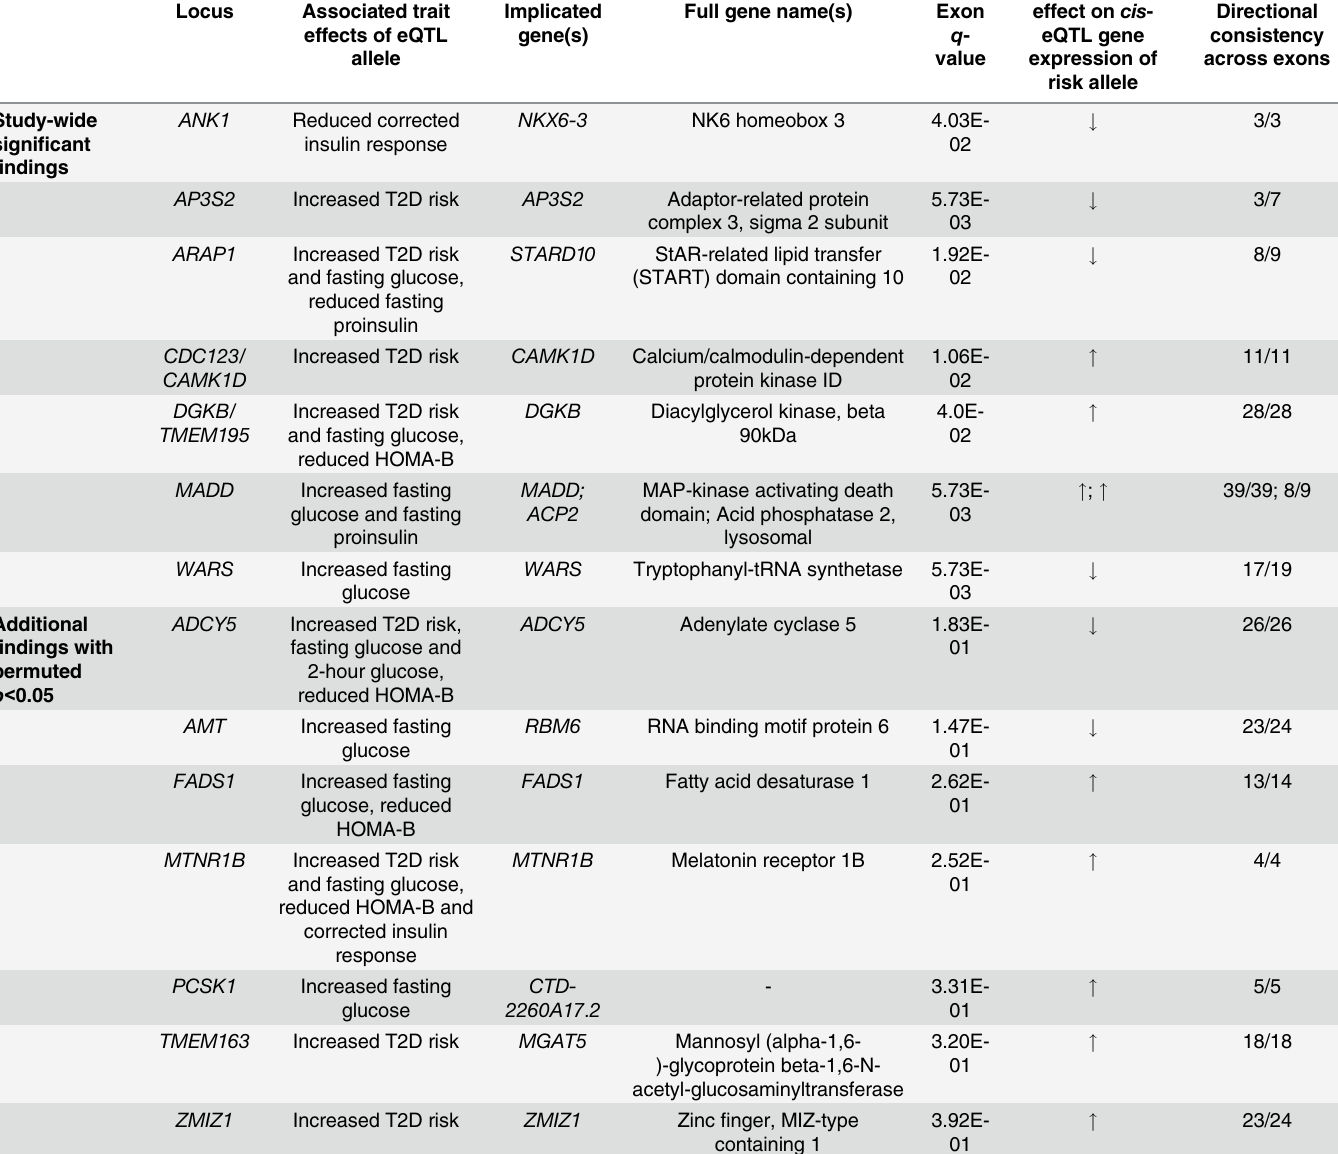
Table 1. Fourteen loci with co-localizing islet exon-eQTL and GWAS signals at loci for T2D and glycemic traits. Information on each of the fourteen loci for type 2 diabetes and/or glycemic traits where islet eQTL data provided putative effector transcripts. * Effect on gene expression is given for the allele associated with the trait effect directions in the column “ Associated trait effects of eQTL allele ”